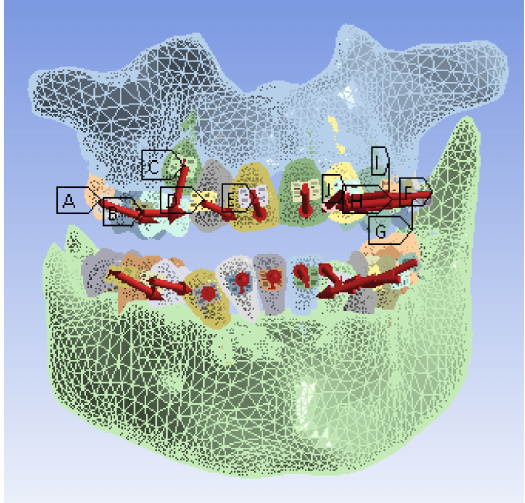
Figure 27. The forces defined in Ansys for the analyzed